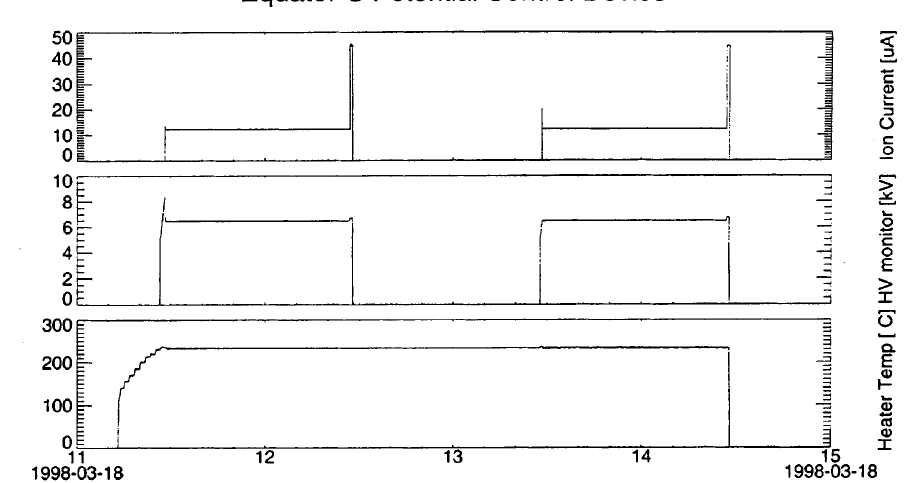
Fig. 2. Routine operation of the instrument PCD. From top to bottom : ion current, operating voltage, and